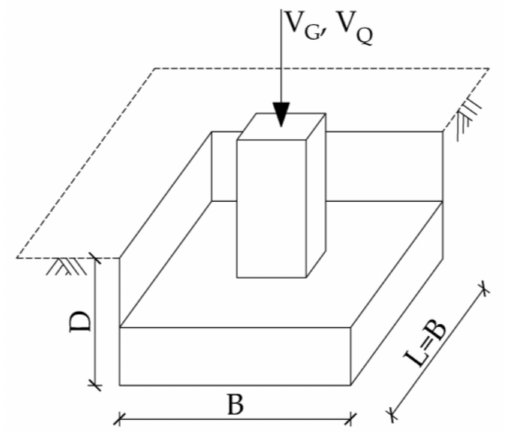
Figure 9. The geometry of the computation